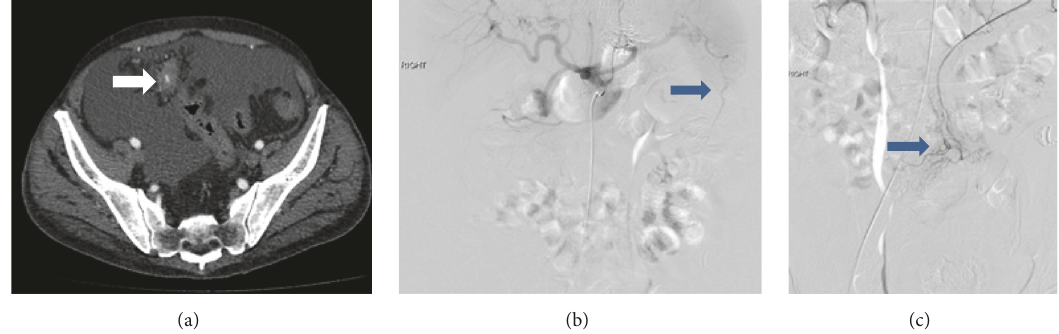
Figure 3: Case 2: Figures 3(a), 3(b), and 3(c). (a) Axial postcontrast CT showing contrast extravasation and surrounding haematoma within the lipomatous lesion (white arrow). Large amount of low density ascities is noted. (b & c): Selective catheterisation of the coeliac axis demonstrated an aberrant artery arising from the splenic artery crossing the midline to the right lower abdomen in the region of the acute haematoma terminating in abnormal cork screw vessels (blue arrows ).